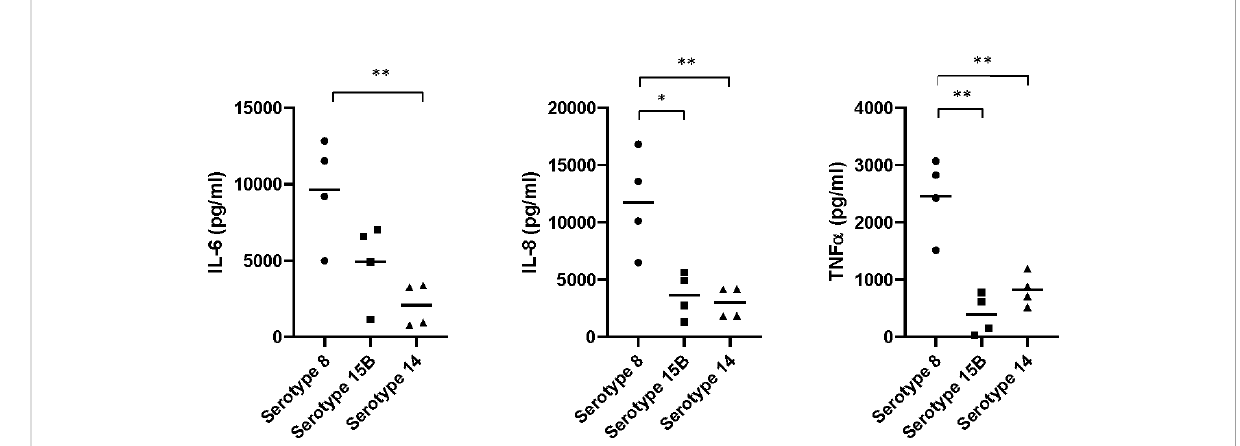
FIGURE 5 Neuroin fl ammatory response of mouse mixed glia to pneumococci of serotypes 8, 15B and 14. Release of pro-in fl ammatory cytokines (IL-6 and TNF a ) and the neutrophil-attractant IL-8 (CXCL2) by glial cells (mixed cultures of astrocytes and microglia) in response to challenge with lysed bacteria. The values are from four independent experiments, the bar indicates the mean, * p<0.05, **